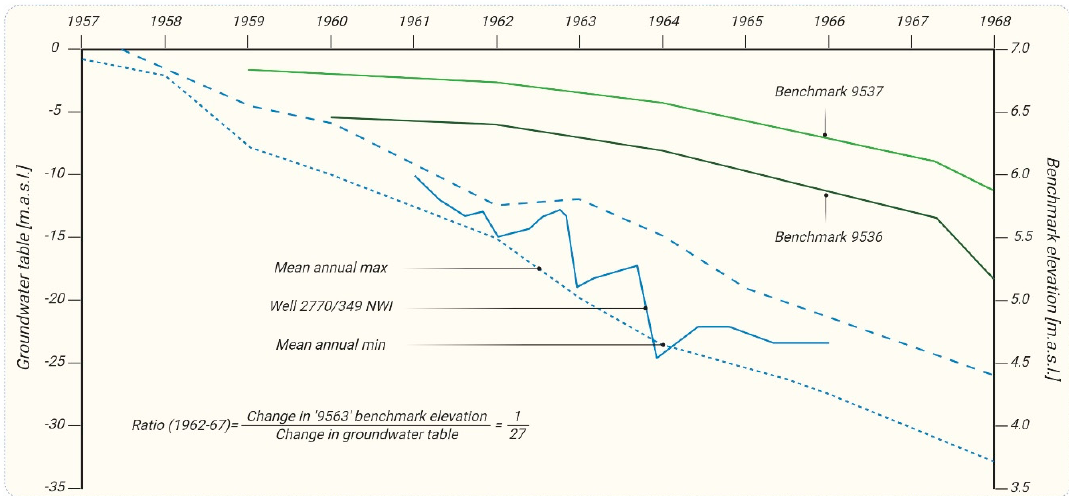
Figure 9. Change in land subsidence and groundwater head observed in selected benchmarks and surrounding pumping wells in Taipei, Taiwan, respectively; modified after [155].